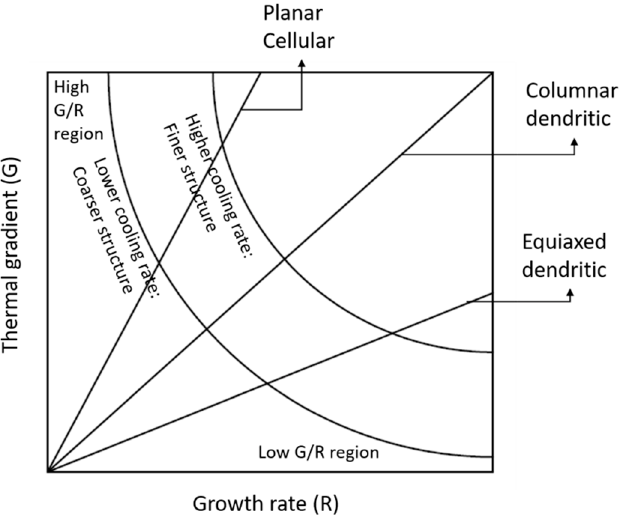
Figure 12. Effect of cooling rate on solidification microstructure related to thermal gradient and growth rate [182].